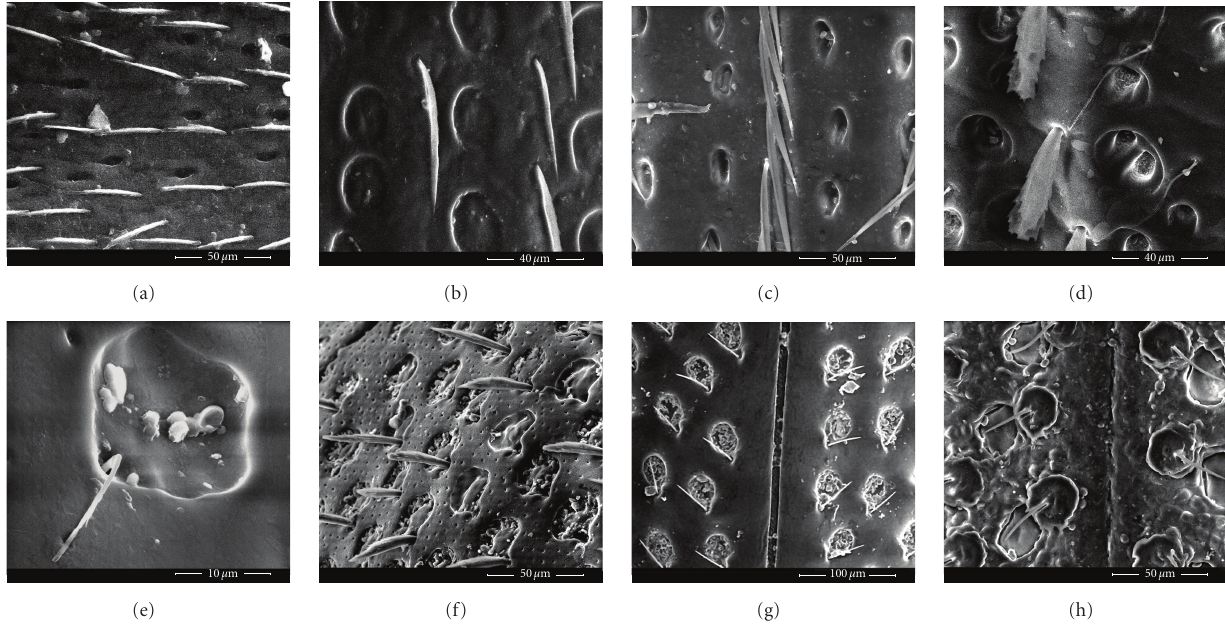
Figure 1: Microsculptures. (a) Trogoxylon impressum (Comolli 1837), (b) Minthea bivestita Lesne 1937, (c) Lyctus carbonarius Waltl 1832, (d) Minthea squamigera Pascoe 1866, (e) Dinoderus minutus (Fabricius, 1775), (f) declivity of D. minutus , (g) Stephanopachys substriatus (Paykull 1800), (h) Stephanopachys rugosus (Olivier 1795).